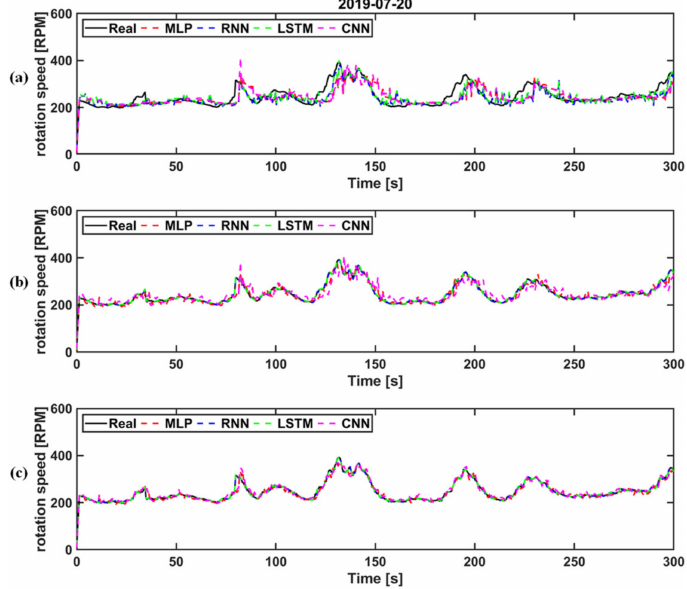
Figure 14. Comparison of prediction performances as a function of the number of input datasets for each algorithm (20 July 2019): ( a ) the two datasets with the highest correlation; ( b ) six datasets with high correlation; and ( c ) all training data.